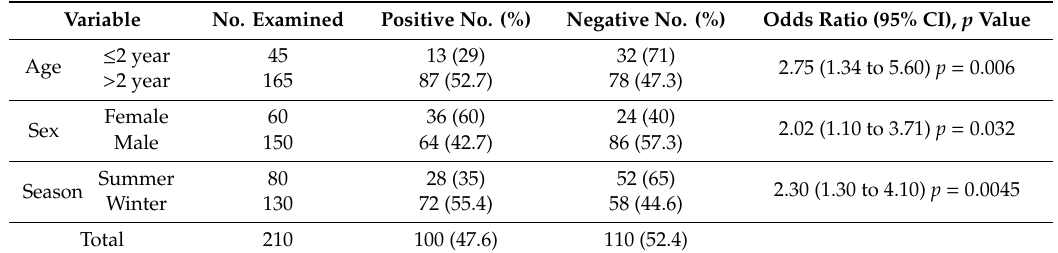
Table 2. Prevalence of camel mange adjusted for age, sex and season.